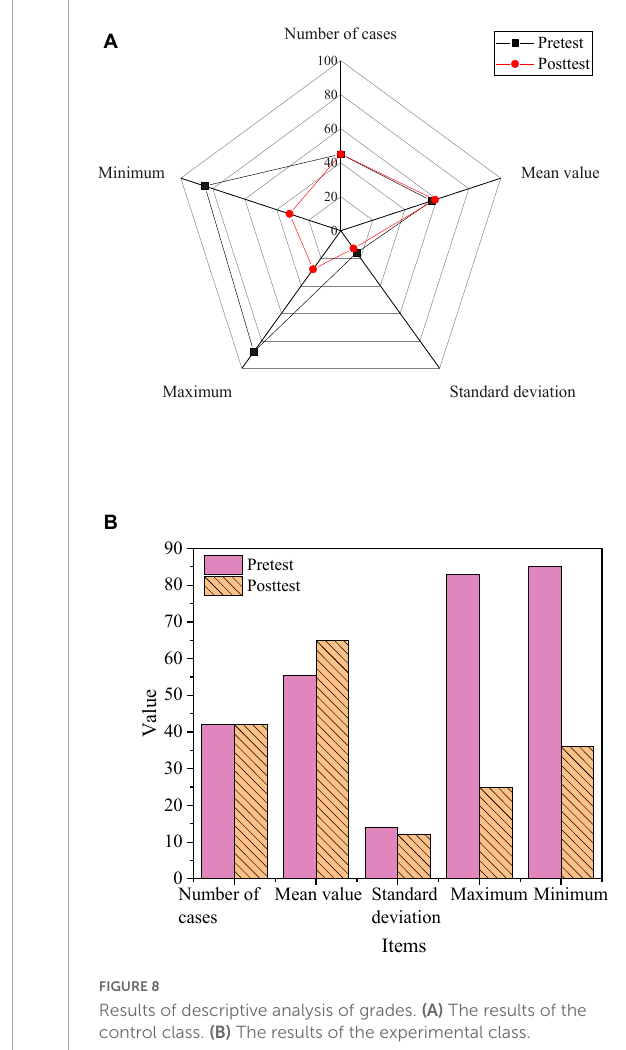
FIGURE8 Results of descriptive analysis of grades. (A) The results of the control class. (B) The results of the experimental